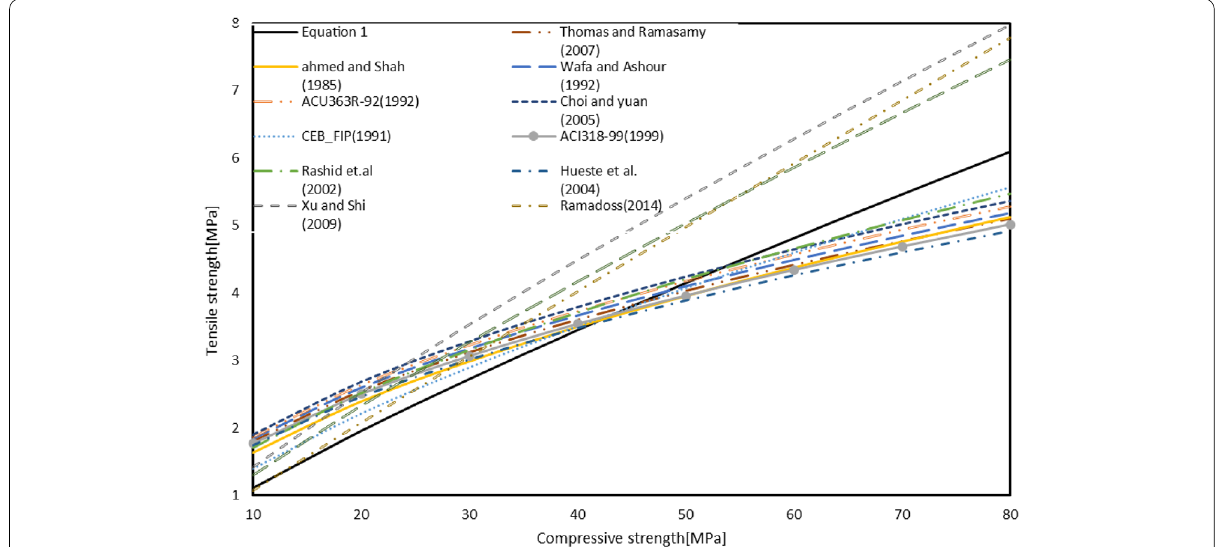
Fig. 4 Comparison of previous equations with presented equation in this